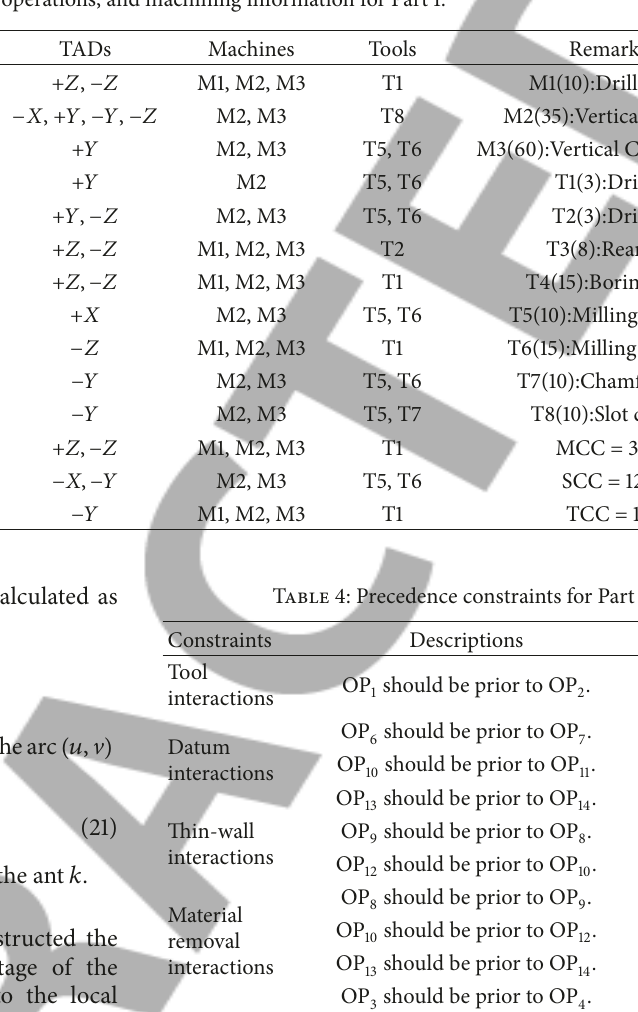
Table 3: Features, operations, and machining information for Part 1.